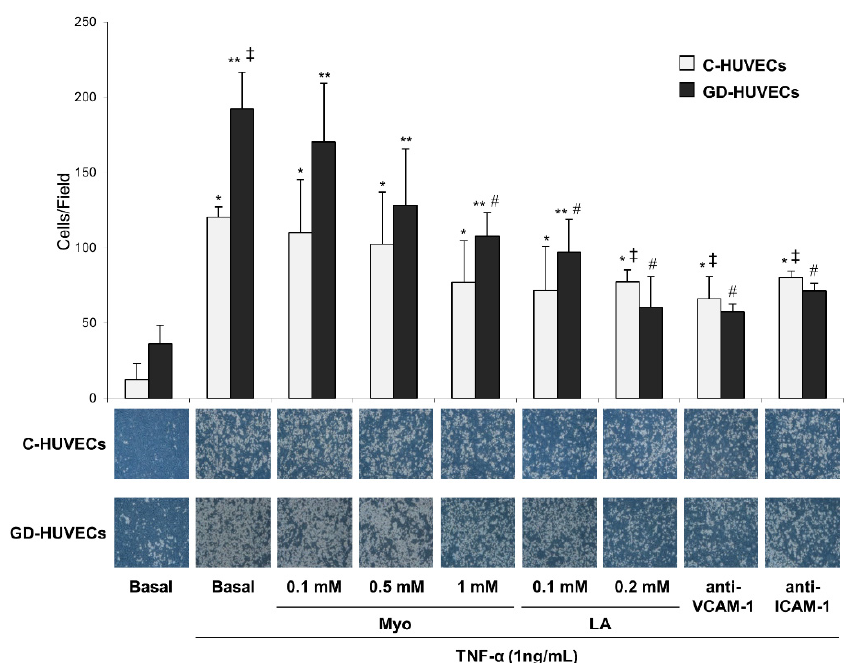
Figure 2. Effect of in vitro treatment with Myo on TNF- α -induced monocyte interaction in C- and GD-HUVECs. In the lower side are representative photos of C- and GD-HUVECs for each experimental condition. * p < 0.01 vs. Basal C-HUVECs, ** p < 0.005 vs. Basal GD-HUVECs, ‡ p < 0.05 vs. TNF- α C-HUVECs, # p < 0.05 vs. TNF- α GD-HUVECs.